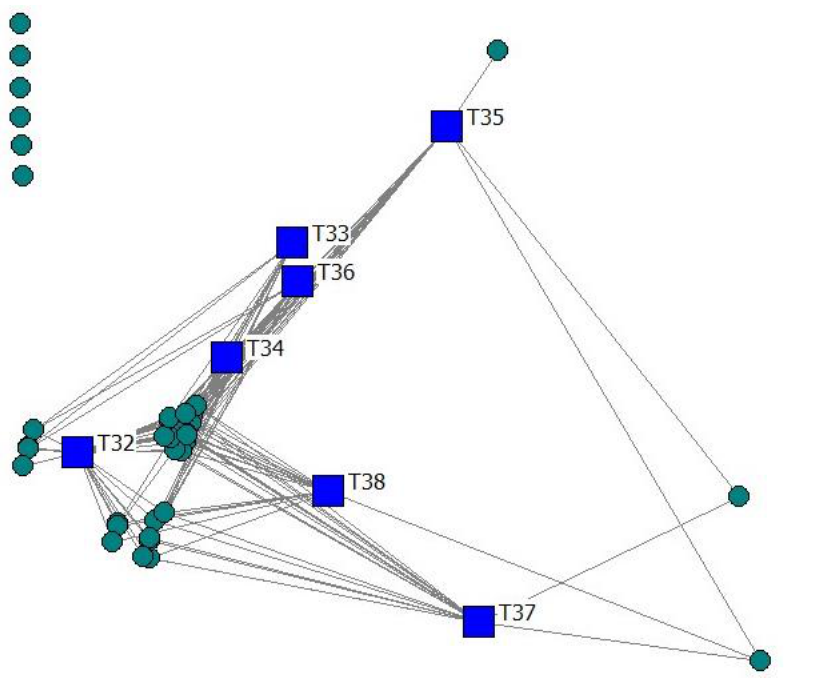
Figure 2. Two-mode network visualization of farmers and technologies. Technologies, Farmer: Men. Table 5. Centrality measures descriptive statistics for technological packages (Mean ± SD (CV, %) 1